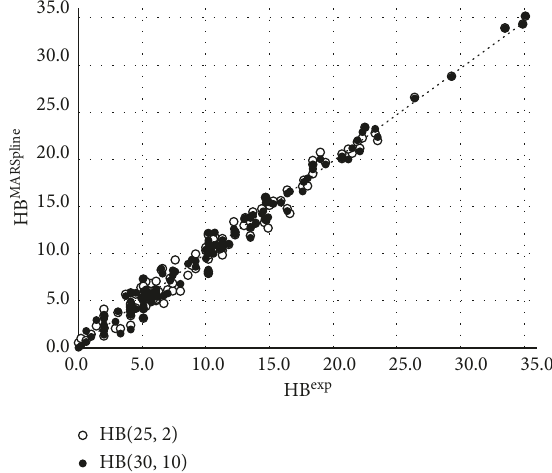
Figure 6: The correlation between experimental and computed values of parameter HB. Prediction is done using Eq. (1). The quality of the chosen optimal HB(25,2) model is characterized by the fitting criteria: R 2 � 0.9812, ( R adj ) 2 � 0.9773, LOF � 2.4449,